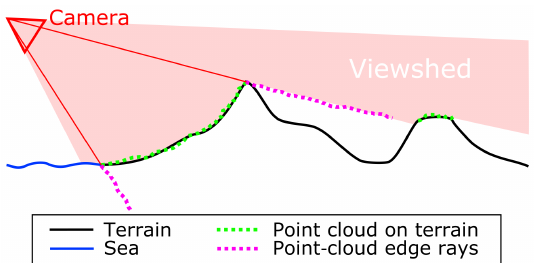
Figure 5. Representation of erroneous data points created by moun- tain ridges and seashore in the approximate direction of the optical rays. Note that the terrain occluded by the foreground mountain, and therefore not included in the viewshed, is not represented in the point